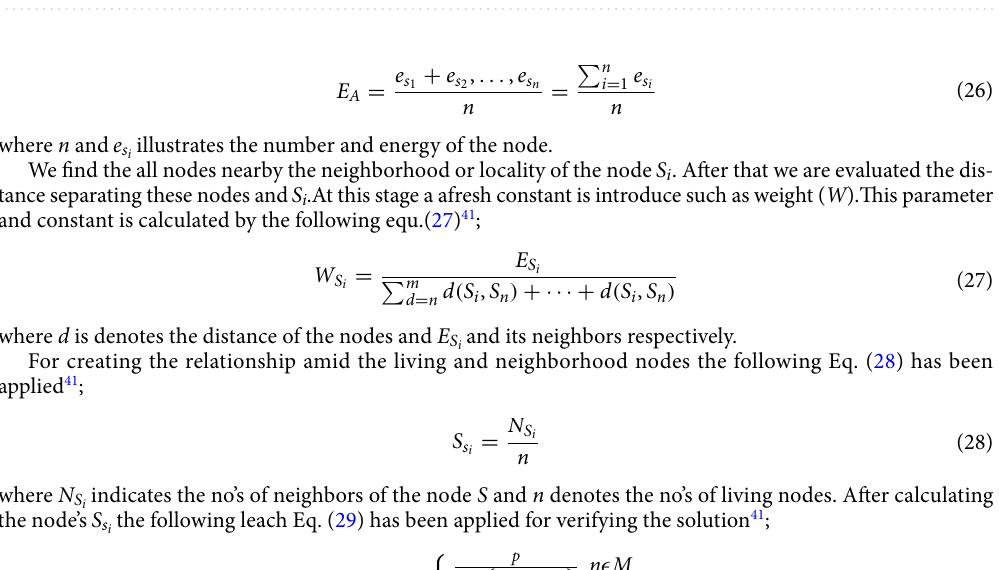
Figure 3. Convergence graphs of evolutionary algorithms on uni-modal test